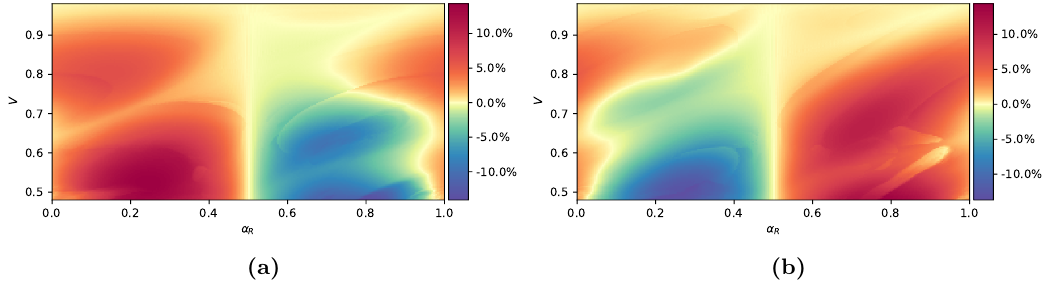
Figure 34 . Balance of energy after the interaction (in percentage of incident energy) for each oscillon, where (a) is for the left outgoing main oscillon and (b) the right outgoing main oscillon.